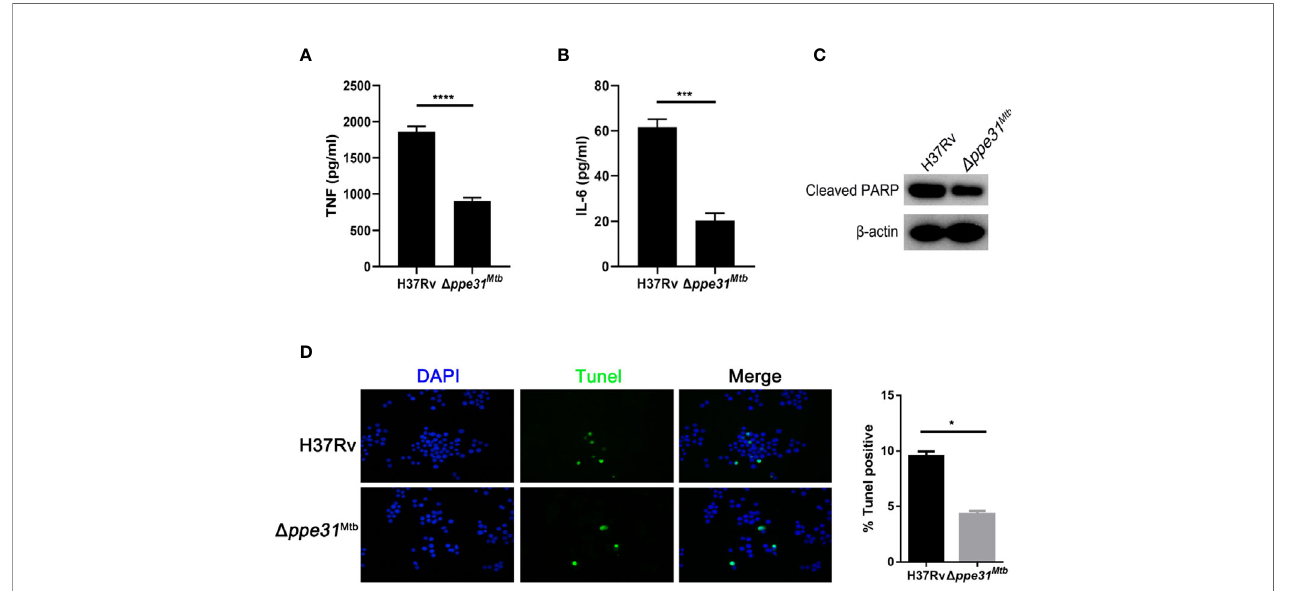
FIGURE 5 | Mutants for ppe31 Mtb decreases the in fl ammatory cytokine expressions and reduces host cell death. RAW264.7 cells were infected with H37Rv or D ppe31 Mtb (MOIs=10) for 24 h. The supernatants were collected, sterile- fi ltered, and assayed for TNF (A) and IL-6 (B) . (C) RAW264.7 were infected with H37Rv or D ppe31 Mtb (MOI = 10) for 24h, and then subjected to Western blot analysis using antibodies raised to cleaved PARP and b -actin. (D) RAW264.7 were infected with H37Rv or D ppe31 Mtb (MOI = 10) for 24h, and cell death was detected by TUNEL staining and then examined by confocal microscope. Data are shown as